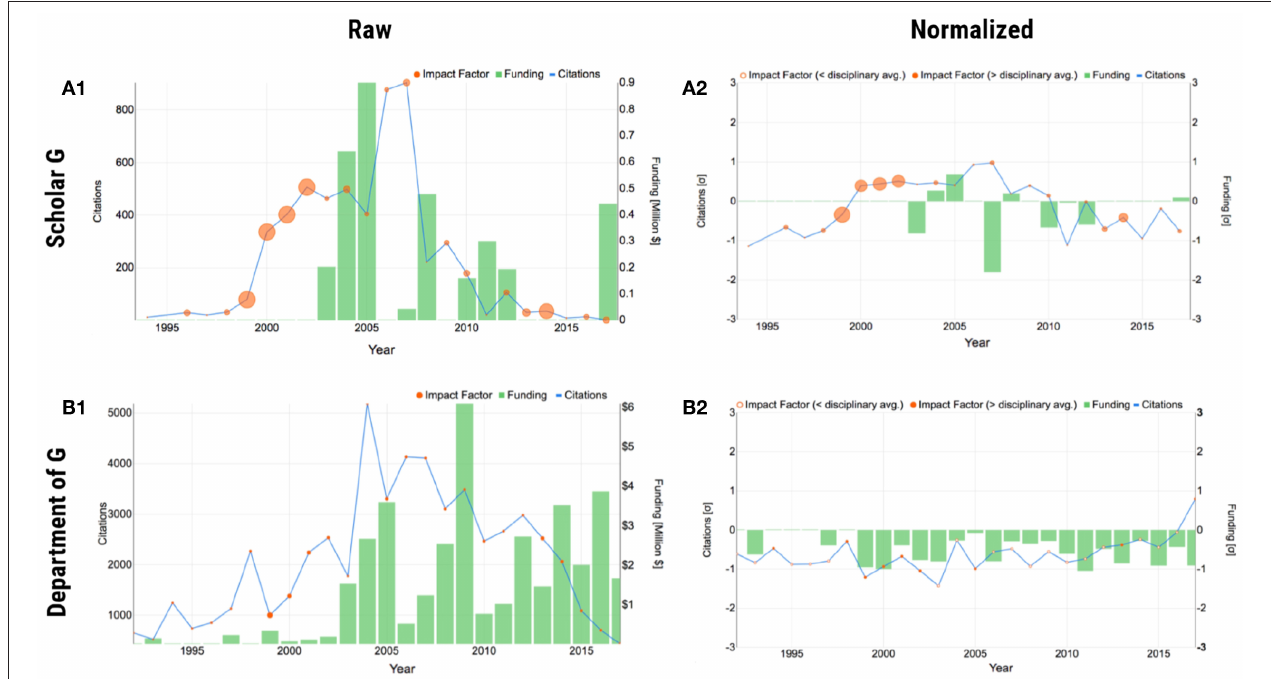
FIGURE 2 | Plot form of SP using scholar G and his department as examples. Scholar G is faculty in the SP database, anonymized for presentation purposes. (A1) Raw individual scholar G. (A2) Normalized individual scholar G. (B1) Raw department of scholar G. (B2) Normalized department of scholar G. In the normalized plots, negative z-scores for IF are expressed as hollow